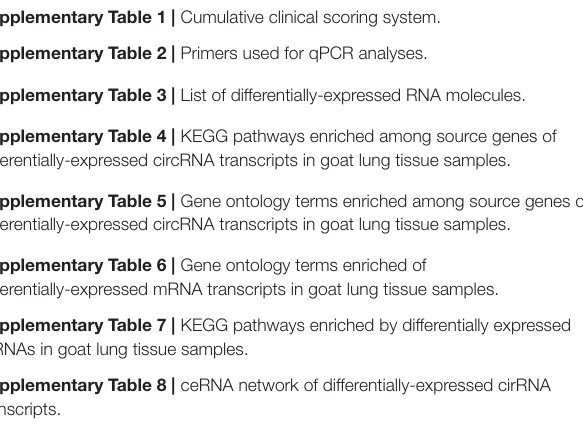
Supplementary Table 8 | ceRNA network of differentially-expressed cirRNA